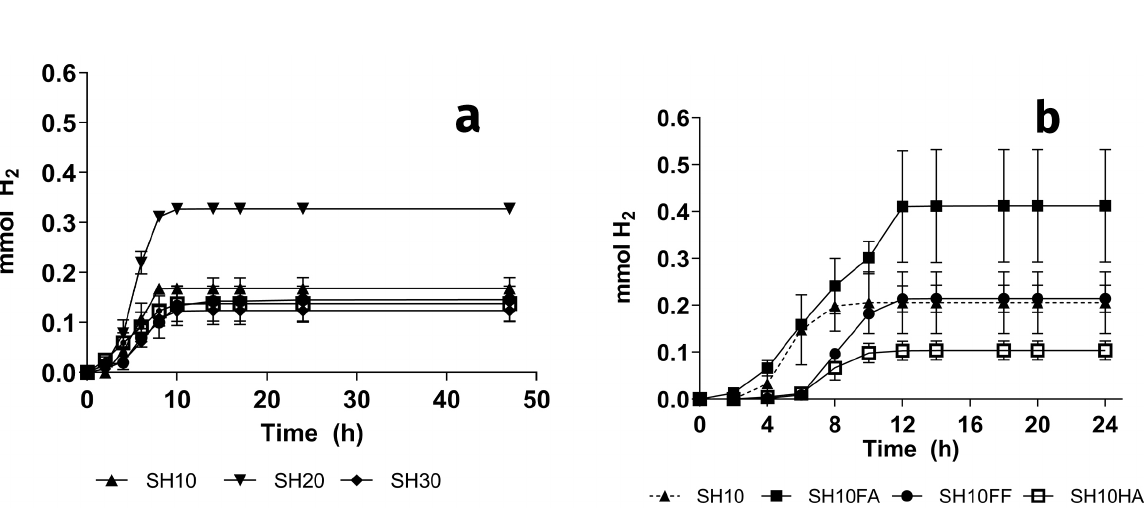
Figure 4. Hydrogen production by Enterobacter sp. LBMT2 during the fermentation of sugarcane hydrolysates. a) synthetic (SH) and sugarcane bagasse hemicellulose hydrolysate (SBH) diluted 10, 20 and 30 times. b) SH10 fermentation with addition of formic acid (FA) furfural (FF) and acetic acid